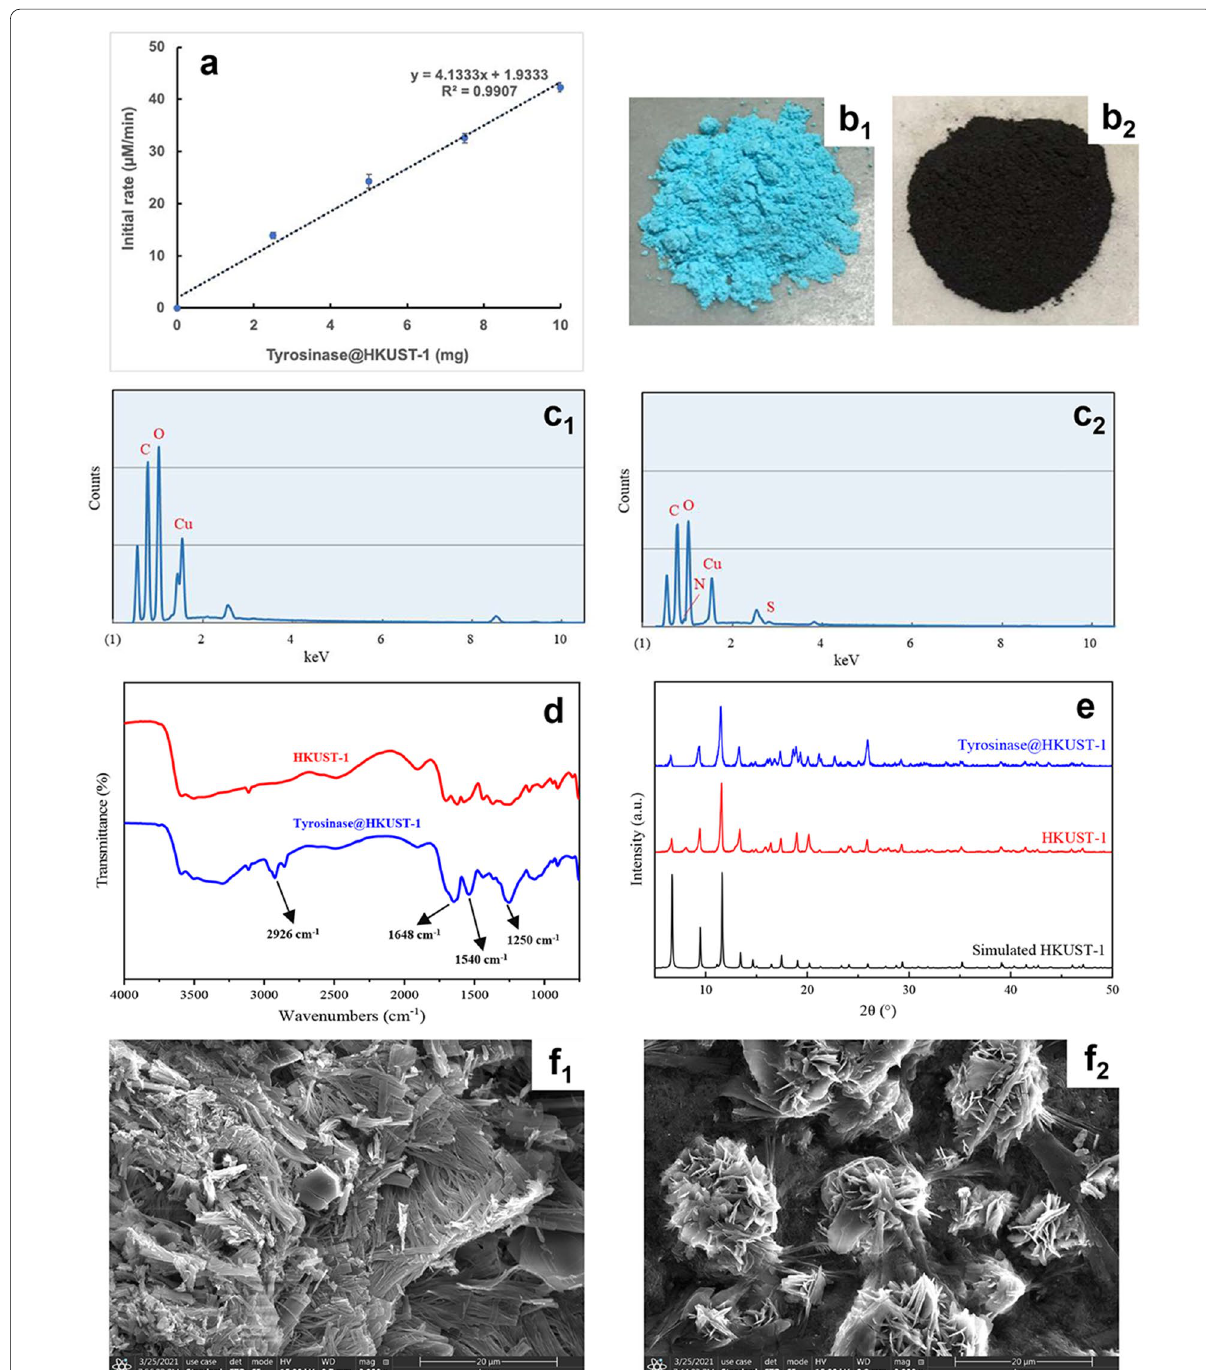
Fig. 1 Characterization of tyrosinase@HKUST‑1: ( a ) activity assay; ( b ) photos of HKUST‑1 (b1) and tyrosinase@HKUST‑1 (b2); ( c ) EDS images of HKUST‑1 (c1) and tyrosinase@HKUST‑1 (c2); ( d ) FT‑IR spectra of HKUST‑1 and tyrosinase@HKUST‑1; ( e ) XRD images of HKUST‑1 and tyrosinase@ HKUST‑1 as compared to that of the simulated HKUST‑1; ( f ) SEM images of HKUST‑1 (f1) and tyrosinase@HKUST‑1